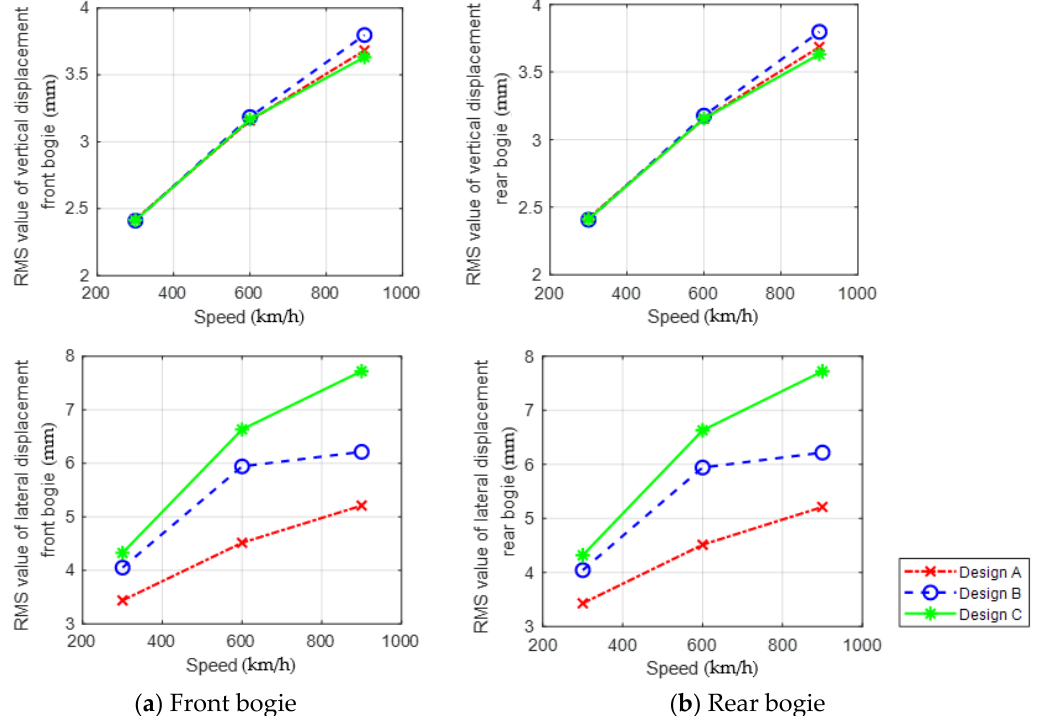
Figure 21. RMS value of the vertical/lateral displacements of the bogie with respect to speed.